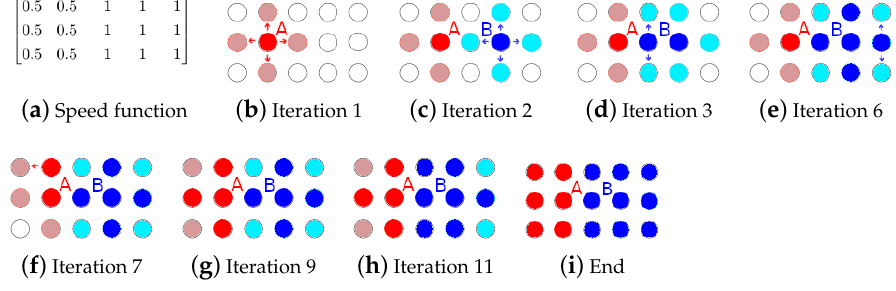
Figure 1. Examples of region assigning.